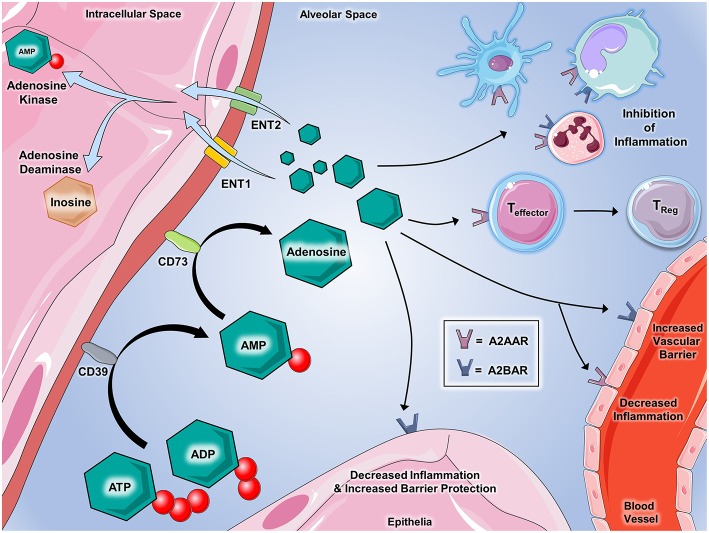
Extracellular adenosine signaling and its termination. Adenosine partakes in a number of signaling events during inflammatory conditions. ATP and ADP that is released serve as the source of extracellular adenosine. CD39 (Ecto-nucleotide triphosphate diphosphohydrolase 1, E-NTPDase1) dephosphorylates extracellular ATP and ADP on the cell surface to generate AMP, which is further dephosphorylated by CD73 (ecto-5'-nucleotidase, Ecto5'NTase) into adenosine. Once generated by enzymatic dephosphorylation, adenosine plays several important roles in regulating inflammation and immunity. Binding with A2AAR and A2BAR on immune cells promotes the inhibition of inflammation mediated by a number of innate immune cells including dendritic cells, monocytes, macrophages, and neutrophils. Adenosine interaction with A2AAR on T cells has demonstrated the suppression of effector functions and promotes the transition to T-regulatory status. On vascular endothelial cells, A2AAR and A2BAR activation decreases cellular inflammatory responses and promotes the integrity of barrier functions, respectively. Epithelial cells from several tissues including lung, gastrointestinal, myocardial, and renal contain A2BAR that, when activated by adenosine, are shown to play critical roles in decreasing inflammation and promoting barrier integrity during inflammation and injury. Several mechanisms are involved in regulating adenosine in order to allow for appropriate termination of signaling. Equilibrative nucleoside transporters (ENT)-1 and−2 deplete the extracellular accumulation of adenosine by transporting it into the nucleus. Adenosine kinase and adenosine deaminase are enzymes that both act to “inactivate” adenosine and inhibit its ability to bind to its receptors. Adenosine deaminase converts adenosine back to AMP and adenosine deaminase converts adenosine to inosine, which is an important step in the metabolism of nucleotides. Components of the figure were modified from SMART Servier Medical Art Library.